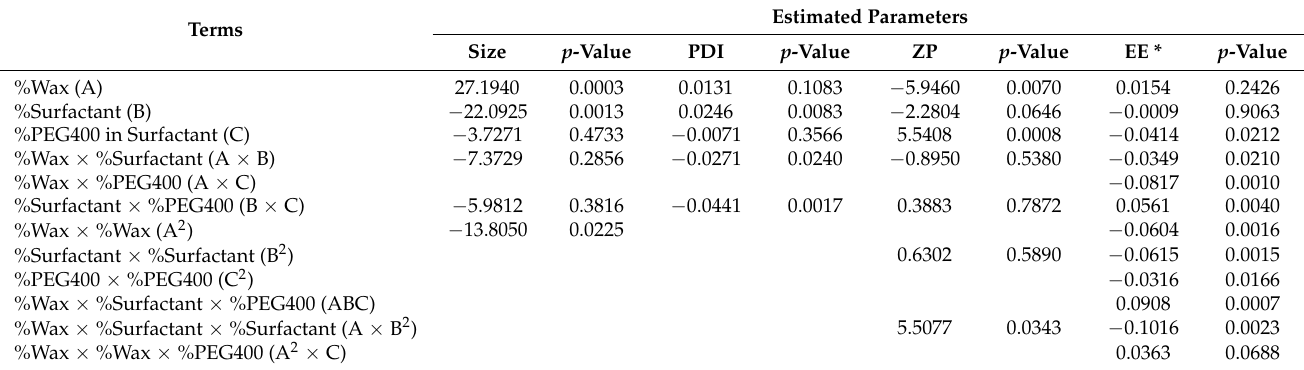
Table 4. The estimated variables for the SBO-NLC preparation and its